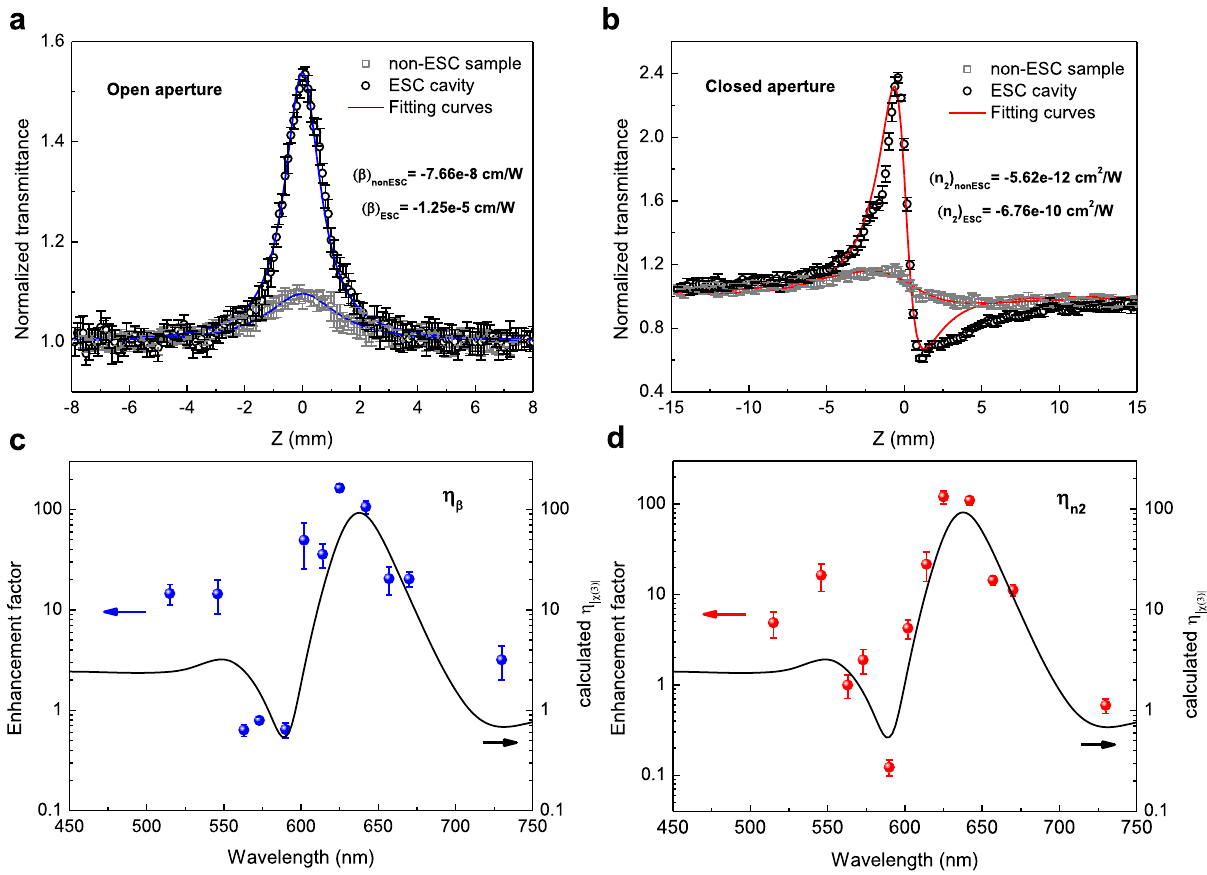
Fig. 2 Nonlinear responses of the coupled and uncoupled systems. Open- a and closed-aperture b Z-scan traces of the J-aggregate cyanine molecules inside (open black circles) and outside (open gray squares) the FP cavities at 625-nm optical illumination. The focal intensity for the non-ESC sample and ESC cavity are 54.5 and 2.73 GW/cm 2 , respectively. The fi tting curves in both ( a and b ) are obtained with a saturation model that is discussed in Methods part. c , d Are enhancement factors of the retrieved n 2 (blue circles) and β (red circles) for various wavelengths. The black curves in ( c and d ) are the calculated enhancement factor of the absolute values of third-order susceptibility from a simpli fi ed nonlinear Lorentz model discussed below. The error bars of each point are calculated from at least three sets of repeated